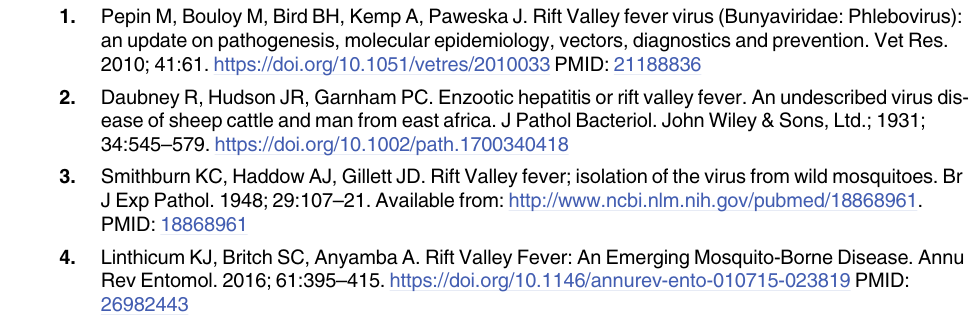
cut-off of P value < 0.0001. Open Reading Frame (ORF) annotations ( � ) were obtained by combining a search performed with the Pfam, Conserved Domain and Swiss-prot databases. The DEG highlighted in green colour corresponds to the immune related DEG identified in the present study.FC = fold change; nr = non-redundant;— = no significant. S3 Table. Down-regulated DEG at 2 hpe and at 3 and 14 dpe with their respective GO cate- gories in RVFV infected Cx . pipiens . DEG were assigned to GO functional categories for bio- logical process using TopGO software with Fisher’s exact test . The cut-off for ‘classicFisher’ was P-value < 0.05. S4 Table. Up-regulated DEG at 2 hpe and at 3 and 14 dpe with their respective GO catego- ries in RVFV infected Cx . pipiens . DEG were assigned to GO functional categories for biolog- ical process using TopGO software with Fisher’s exact test . The cut-off for ‘classicFisher’ was P-value <